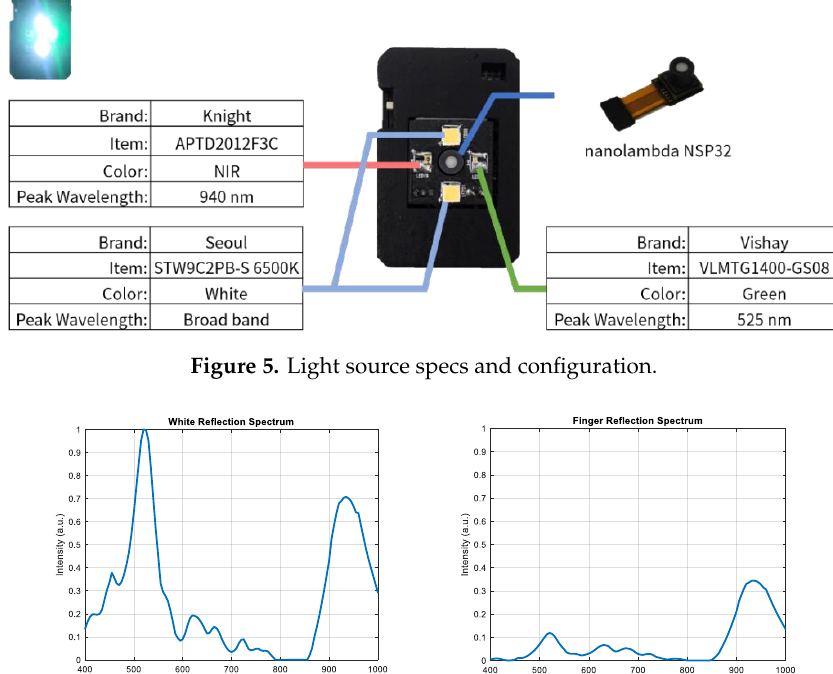
Figure 4. The developed mobile app.